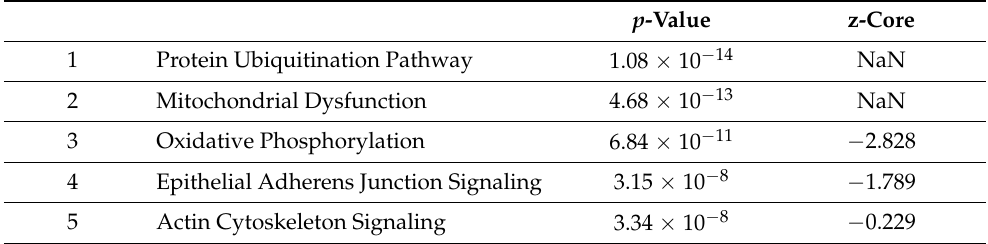
Figure 3. Volcano plot displaying the statistical p -value with the magnitude of fold change between proteins of 661w cells after 48 h incubation under high glucose vs. a normal glycemic control. The non-axial vertical dashed lines denote a fold change, of ± 0.58 Log2 unit (i.e., ± 1.5 − fold change), whereas the non-axial horizontal dashed line denotes 1.30 − Log 10 p -value (i.e., p = 0.05), which is the significance threshold prior to logarithmic transformation. A total of 992 of 2802 proteins were found to be differentially expressed (blue: downregulated; red: upregulated). The top 10 up- and downregulated proteins are labelled. Table 1. The top five significant pathways revealed by pathway analysis using the IPA and their associated p -values (Fischer’s exact test) and z-scores. The z-score represents activation or suppression of the corresponding pathway, with “NaN” denoting unpredicted.